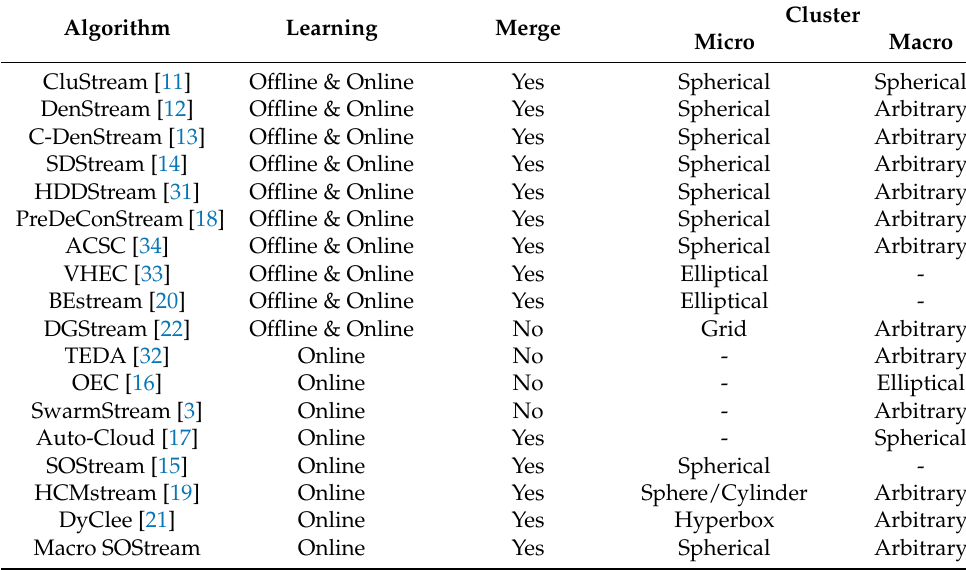
Table 1. Summary of evolving